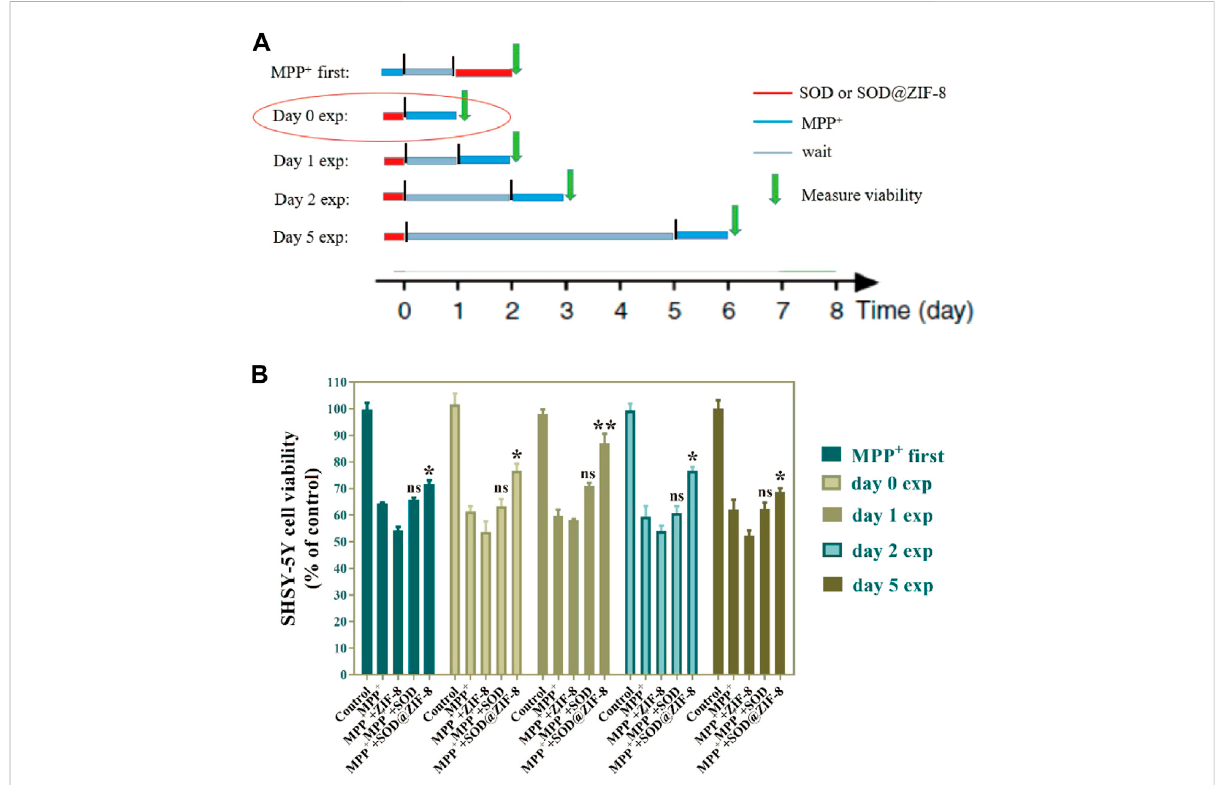
FIGURE 10 Long-term persistence effect of SOD@ZIF-8. Cells were pretreated with MPP + (MPP + fi rst)or pretreated with SOD@ZIF-8 (Day 0 exp to Day 5exp),washedandcontinuedtocultureforseveraldays(graytimeperiodinschematicdiagram)andthenexposedtoMPP + for24 h.Cellviabilitywas quanti fi ed by MTT assay.